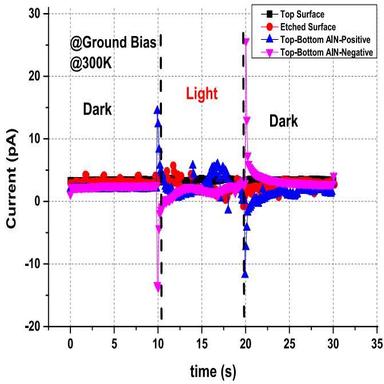
Kinetics of Current under ground biased Dark and luminous condition of AlN stack.